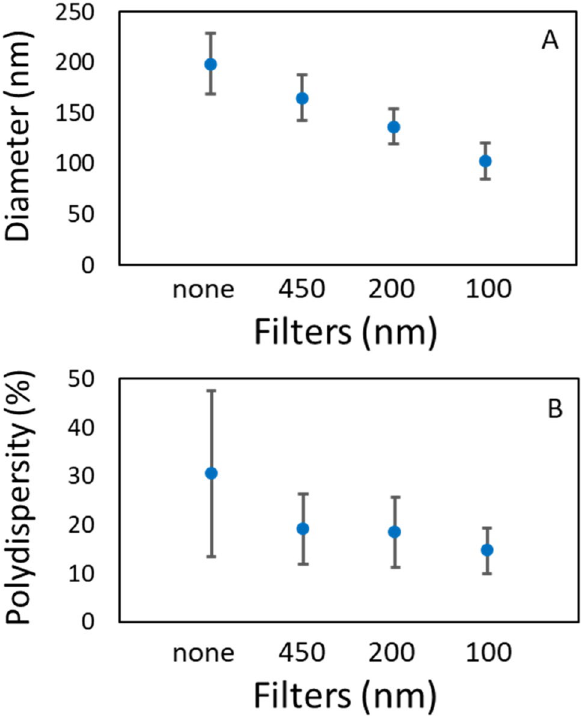
Figure 4. DLS measurements of filtrated PEVF. ( A ) The mean size and standard deviation for different filtrate of a 10× concentrated PEVF. Note that PEVF during the preparation was filtered through a 0.8 µm filter. ( B ) The corresponding polydispersity with standard